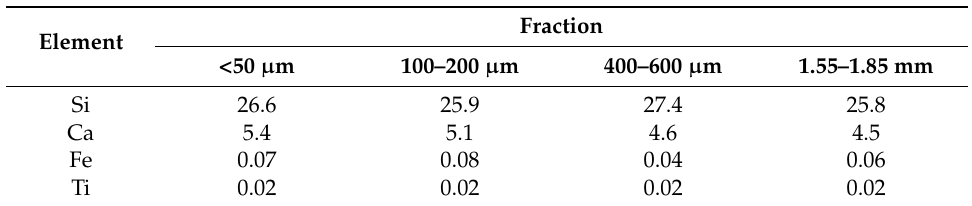
Table 3. The main chemical components of the different glass sphere fractions as percentages in proportion of weight.